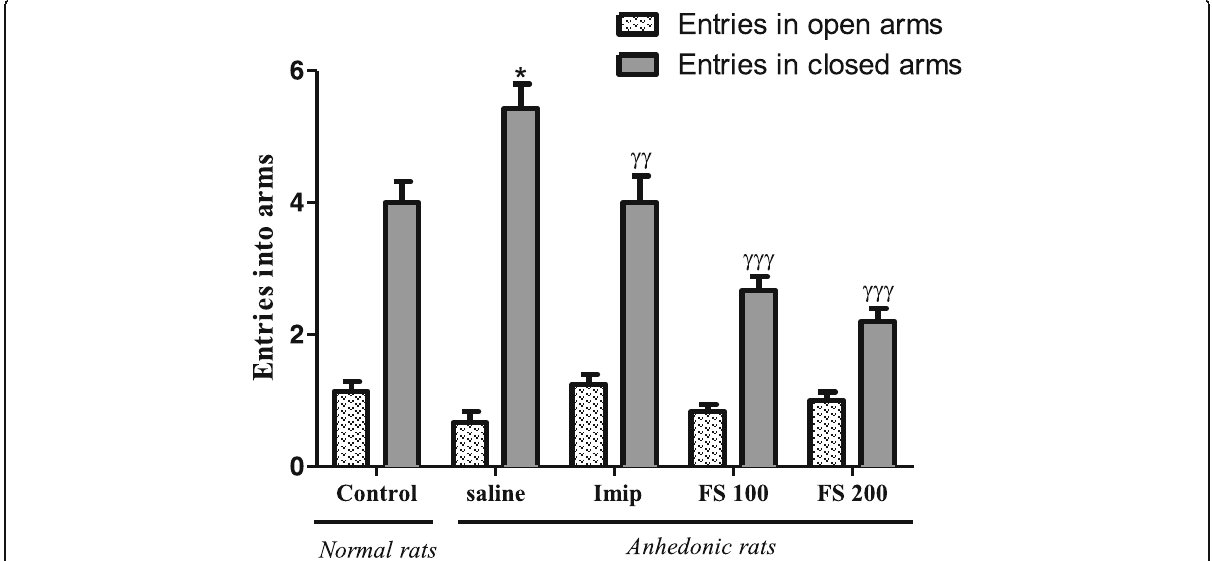
Fig. 10 Effect of the hydromethanolic extract of F. sycomorus on the number of entries in open and closed arms. Imip: imipramine, FS: Ficus sycomorus